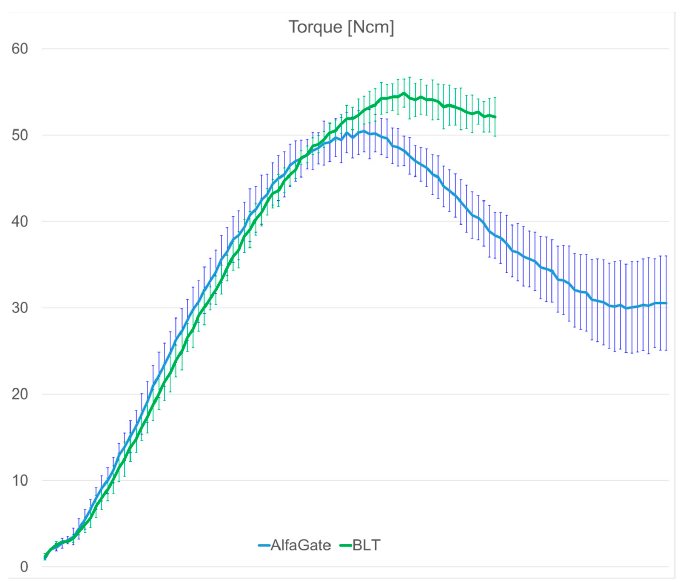
Figure 3. Torque development over time during implant insertion for both groups investigated showing an overall torque increase with insertion depth for Straumann BLT while lower maximum torque was required in AlfaGate implants coinciding with the bulky central part of the implant passing the cortical plate.